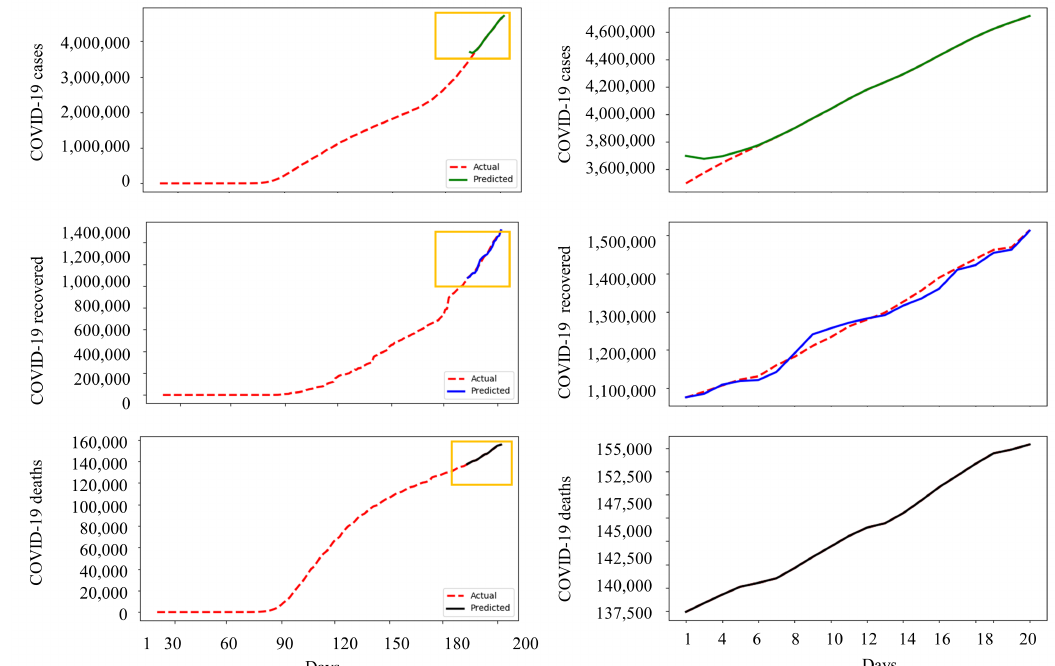
Figure 9. The 25 days ahead trend prediction in USA, COVID-19 cases (row 1), recovered (row 2), and deaths (row 3).